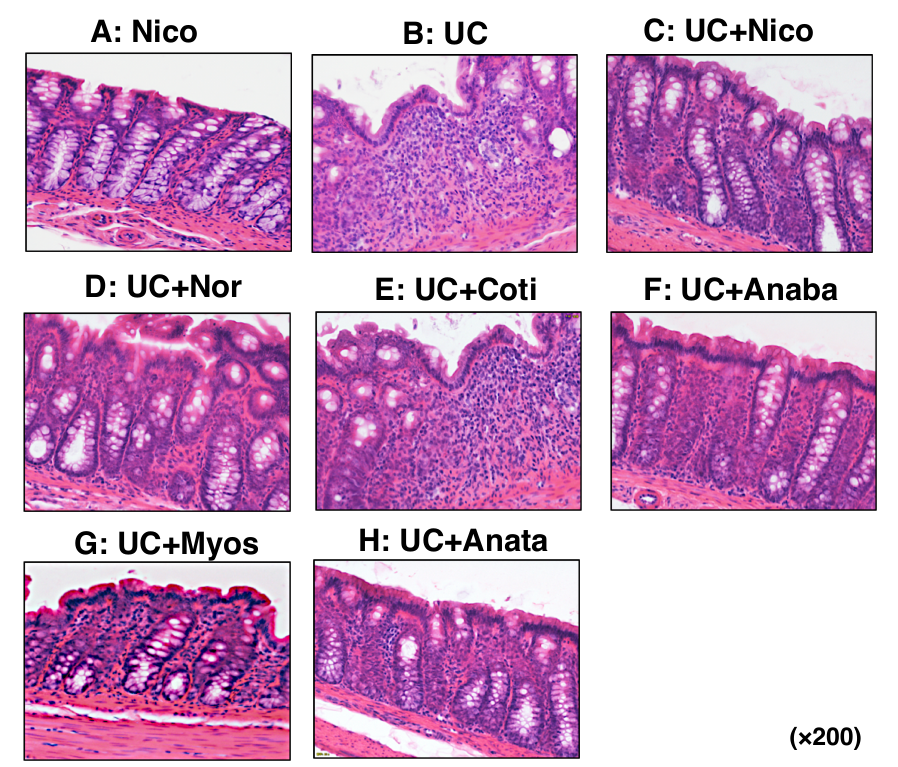
Figure 5. Evaluation of histological severity in colonic tissues of rats. ( A – H ) Microscopic images of colon tissues of from the Nico, UC, UC + Nico, UC + Nor, UC + Coti, UC + Anaba, UC + Myos, and UC + Anata groups, respectively. All microscopic images were observed using a BIOREVO BZ-9000 microscope (Keyence Co., Ltd., Osaka, Japan). High-power magnification was used for all panels ( × 200). Anaba, anabasine; Anata, anatabine; Coti, cotinine; DAI, disease activity index; HIS, histological; Myos, myosmine; Nico, nicotine; Nor, nornicotine; and UC, ulcerative